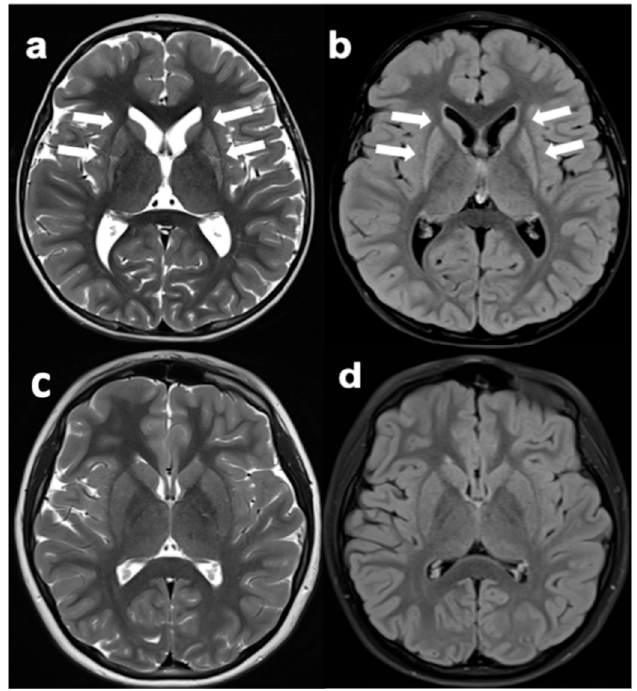
Figure 3. MRI (Magnetic Resonance Imaging) in a HE-PHD (highly expanded- pediatric Huntington disease) patient (Patient 3) and in a subject with suspicious motor manifestations of PHD. ( a ), ( b ) Patient 3 with a pathological total motor score = 21 performed MRI at the very beginning of PHD (MRI age = 5, age at onset = 3.5). Atrophy and slight signal hyperintensity of the caudate nuclei and